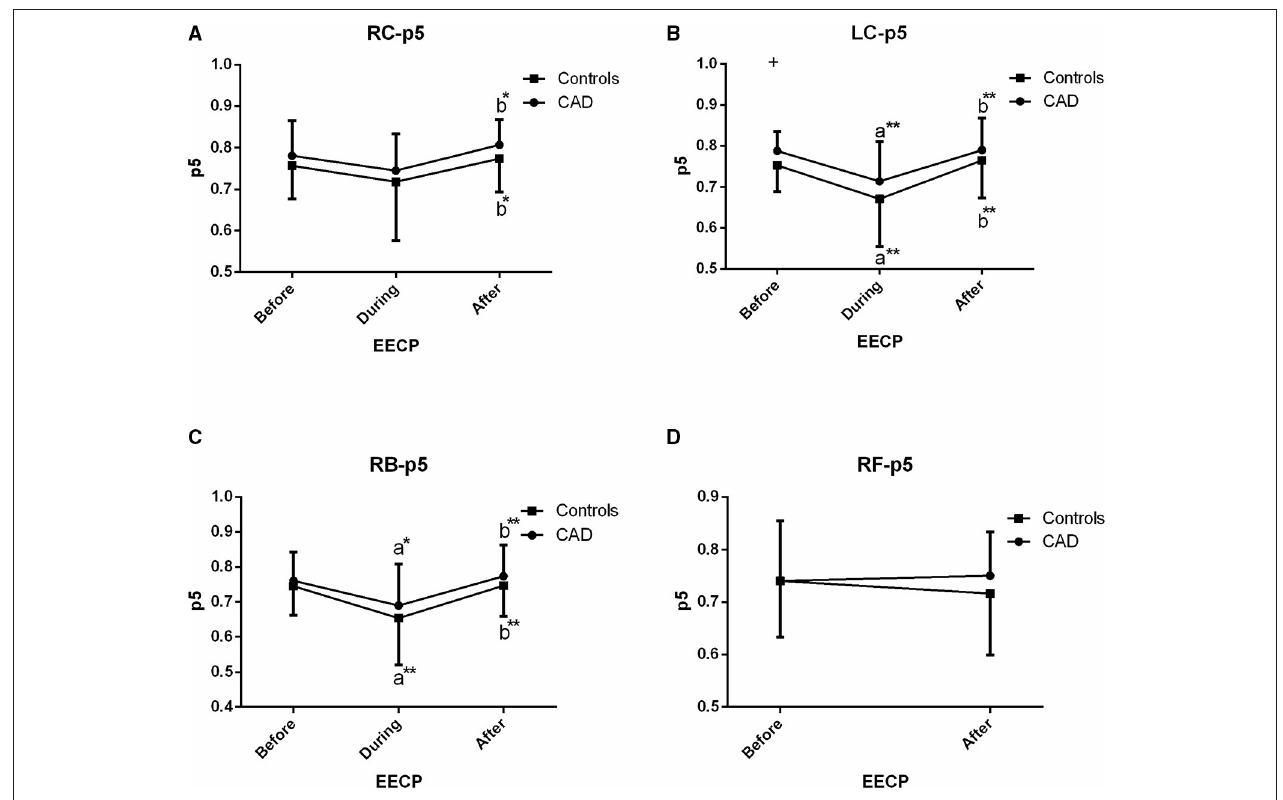
FIGURE 7 | Effect of EECP on the PSER in the 0–2.05Hz (p5) of LC and RC arteries (A,B) , RB artery (C) , and RF artery (D) in patients with CAD and controls before, during and after 45-min EECP. a indicates significant differences in measurements obtained during EECP vs. pre-EECP and b indicates differences between post-EECP vs. during-EECP. “*” and “**” denote values of p < 0.5 and < 0.01,